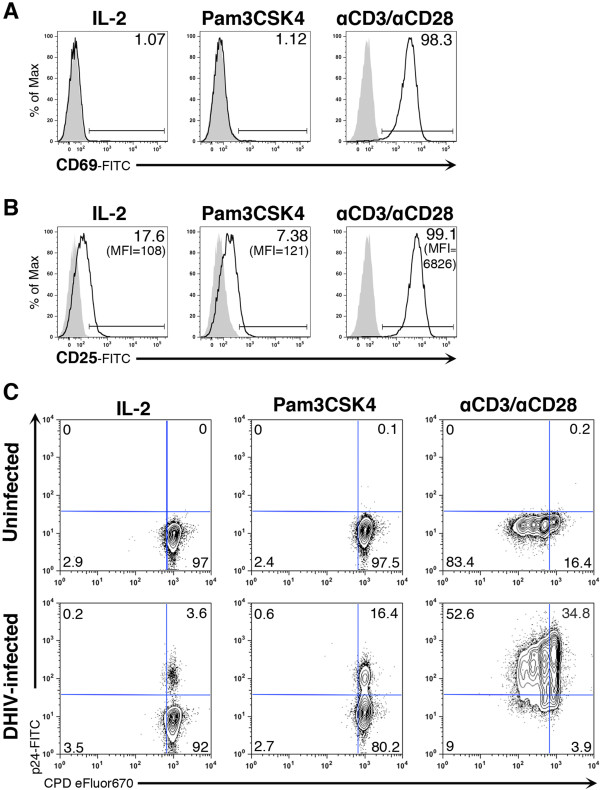
Pam3CSK4 induces viral reactivation in the absence of T cell activation or T cell proliferation. Cultured TCM cells were treated with IL-2, Pam3CSK4 or costimulated with antibodies to CD3 and CD28 (αCD3/αCD28) for 3 days and assessed for the induction of CD69 (A) and CD25 (B) by flow cytometry (open black histograms). Isotype control was used as control (closed gray histogram). The percentage of CD69 and CD25 positive cells is indicated in each panel and the mean fluorescence intensity (MFI) is indicated between parentheses for CD25. Data is representative of three donors. (C) Cultured TCM cells were infected with wild-type DHIV or left uninfected. At 9 days after infection, cells were stained with the cell-proliferation dye CPD eFluor670. Stained cells were treated with IL-2, Pam3CSK4 or costimulated with antibodies to CD3 and CD28 (αCD3/αCD28) for 3 days and assessed for intracellular p24Gag expression and CPD eFluor670 staining by flow cytometry. Numbers indicate percentage of cells. Data is representative of three donors.